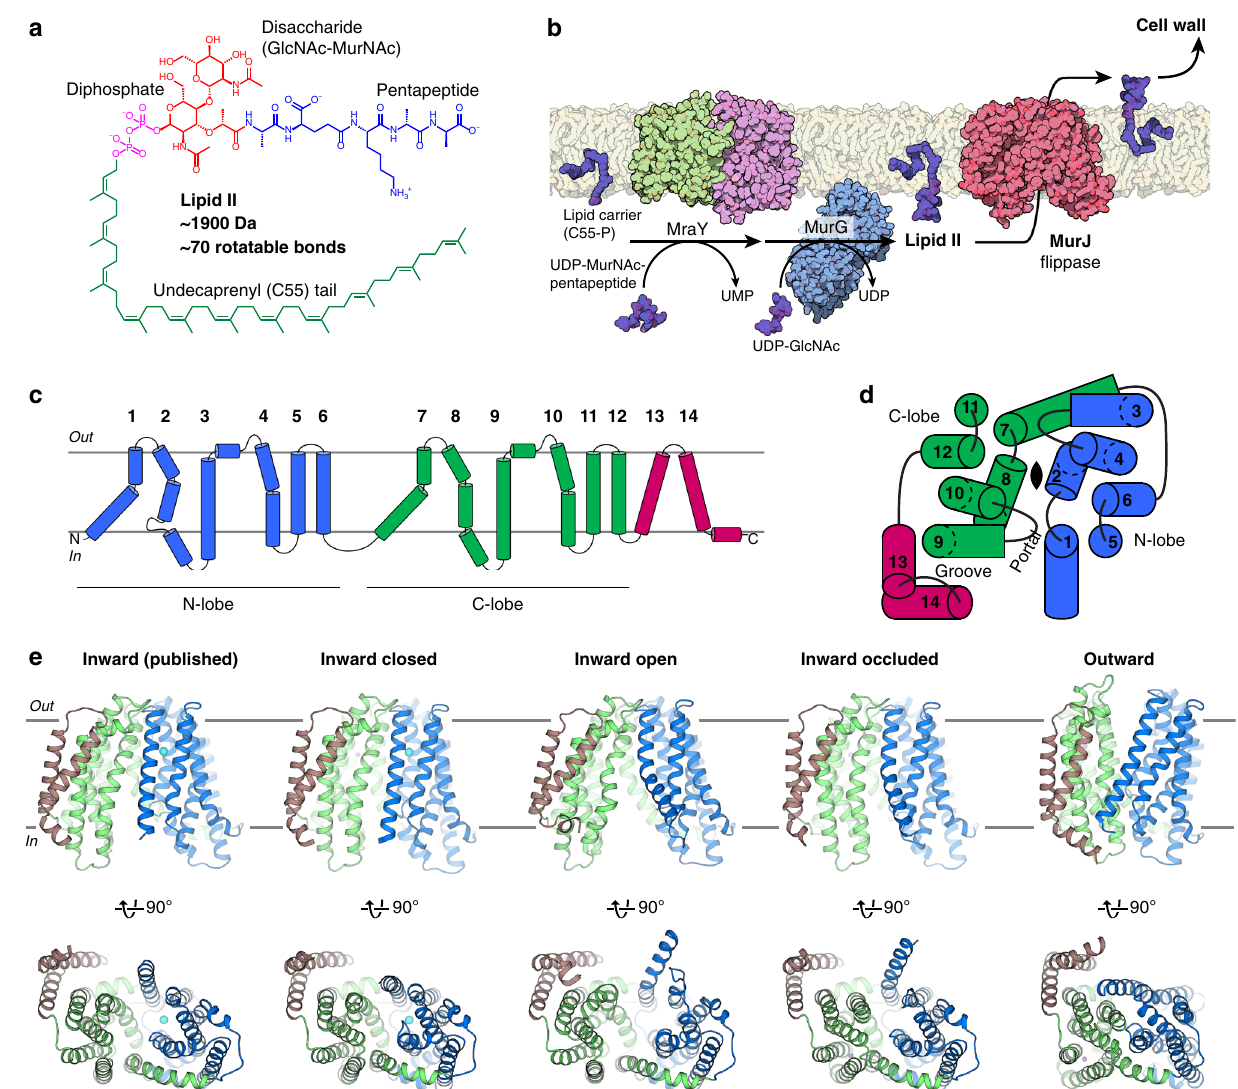
Fig. 1 Crystal structures of the Lipid II fl ippase MurJ TA . a Chemical structure of the peptidoglycan precursor Lipid II. The third residue of the pentapeptide is variable (shown here is L -lysine but could be meso-diaminopimelate in many Gram-negative bacteria). b Lipid II is synthesized by the combined transferase activities of MraY (PDB 4J72) and MurG (1F0K), then fl ipped across the cytoplasmic membrane by MurJ for subsequent incorporation into the cell wall. These steps constitute a prototype lipid-linked oligosaccharide (LLO) transport system. c MurJ contains two 6-helix bundles (N-lobe, blue, and C-lobe, green) common to the MOP superfamily and 2 additional C-terminal helices (brown). d N-lobe and C-lobe are related by pseudo-twofold rotational symmetry normal to the membrane (top view is shown). Symmetry is distorted at TMs 1, 2, 7, and 8 which enclose the central cavity. TMs 13 and 14 form a hydrophobic groove that enters the central cavity through a portal. e Our previous crystal structure of MurJ (5T77), and crystal structures in the inward- closed, inward-open, inward-occluded, and outward conformations (front and bottom views). Resolutions (from left) are 2.0, 3.2, 3.0, 2.6, and 1.8